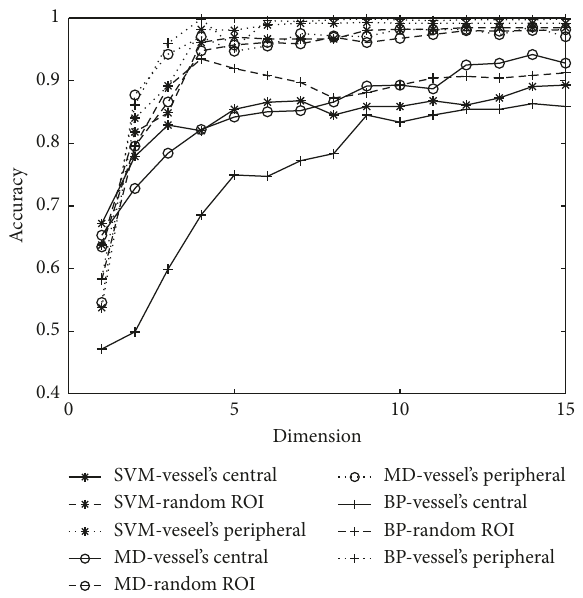
Figure 16: Spectral classification comparisons for 8 wood